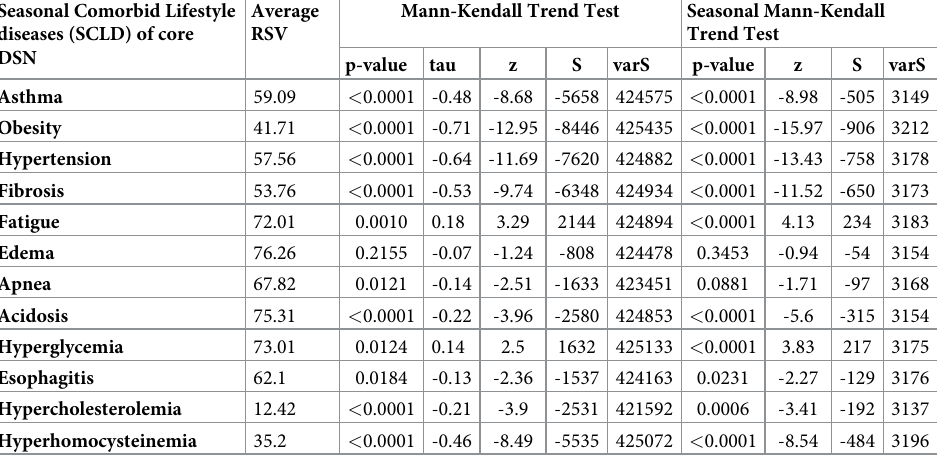
Table 2. Widespread monthly RSV of GT time series seasonal analysis of the core DSN diseases (Jan 2004 to Dec 2016) without the reference term. (Complete raw data is given in S2 Table). Seasonal Comorbid Lifestyle diseases (SCLD) of core